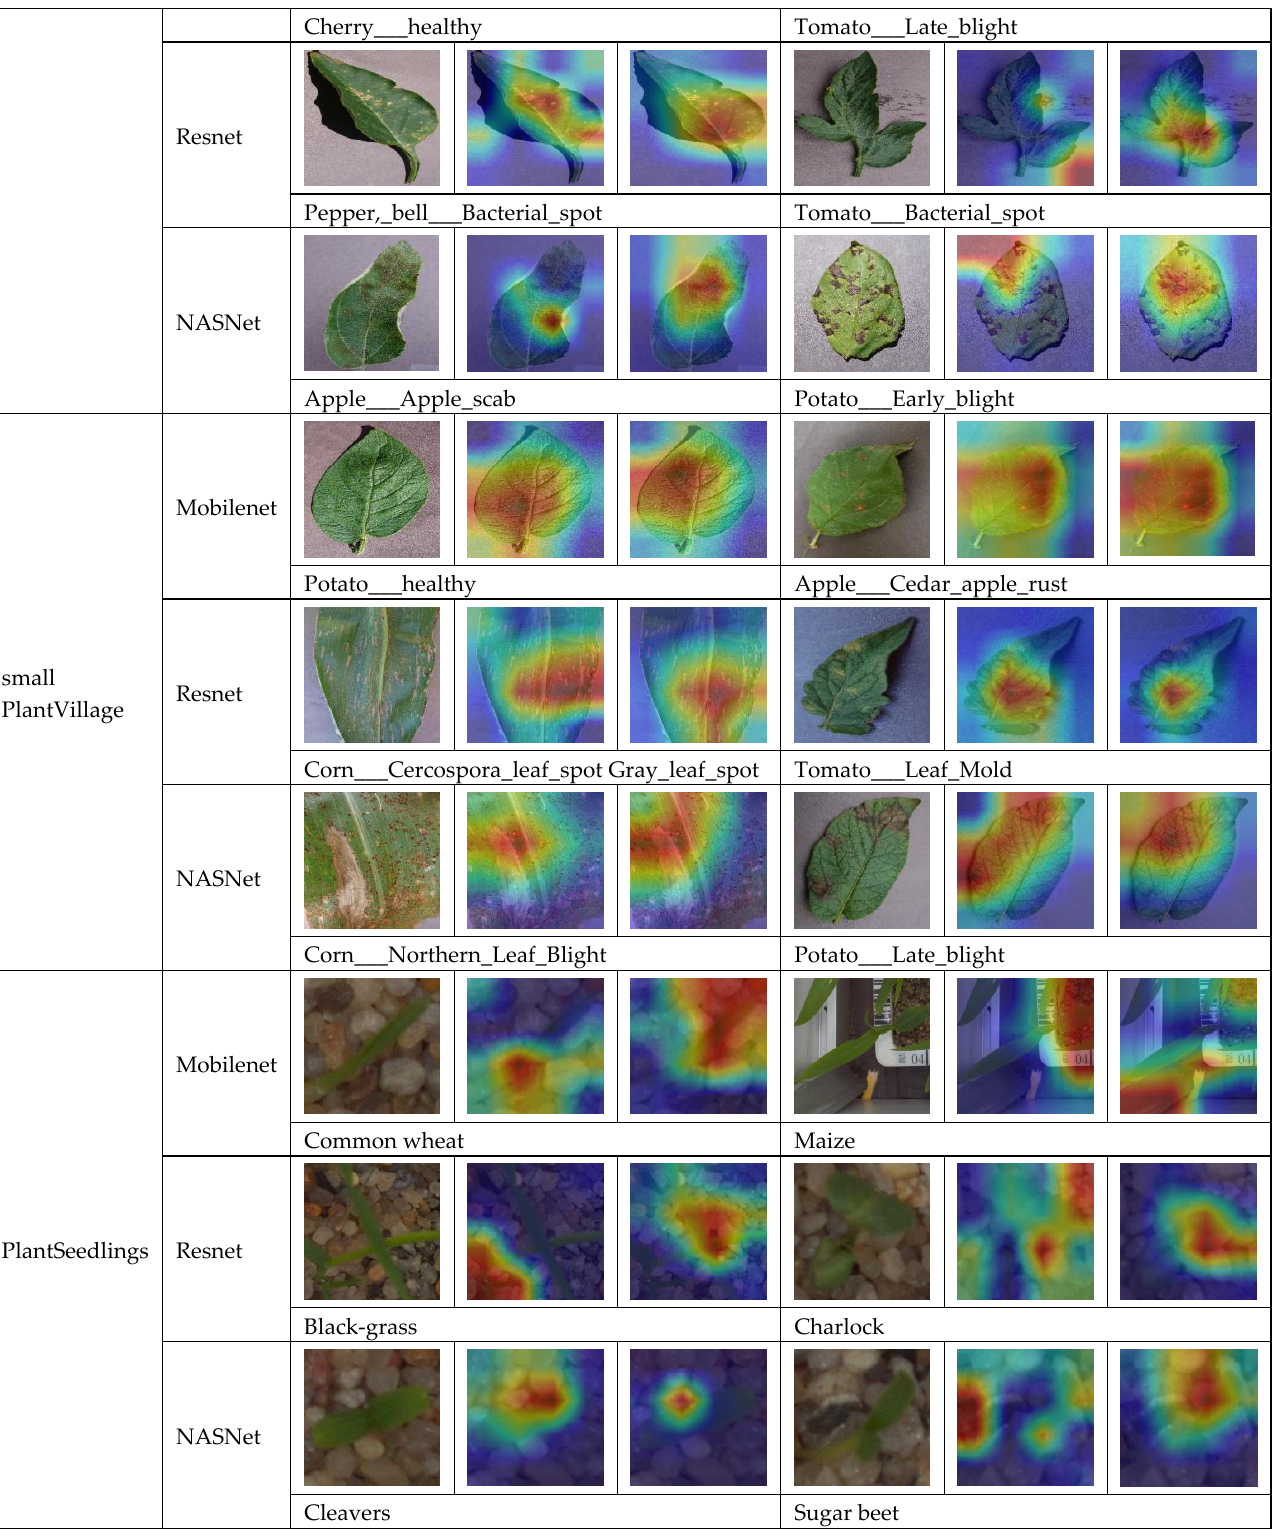
Figure 24. Grad-CAM visualization of models trained by the conventional method and YMufT strategy. The original images were misclassified using the conventional method but classified correctly using YMufT. Below each original image is the species name.